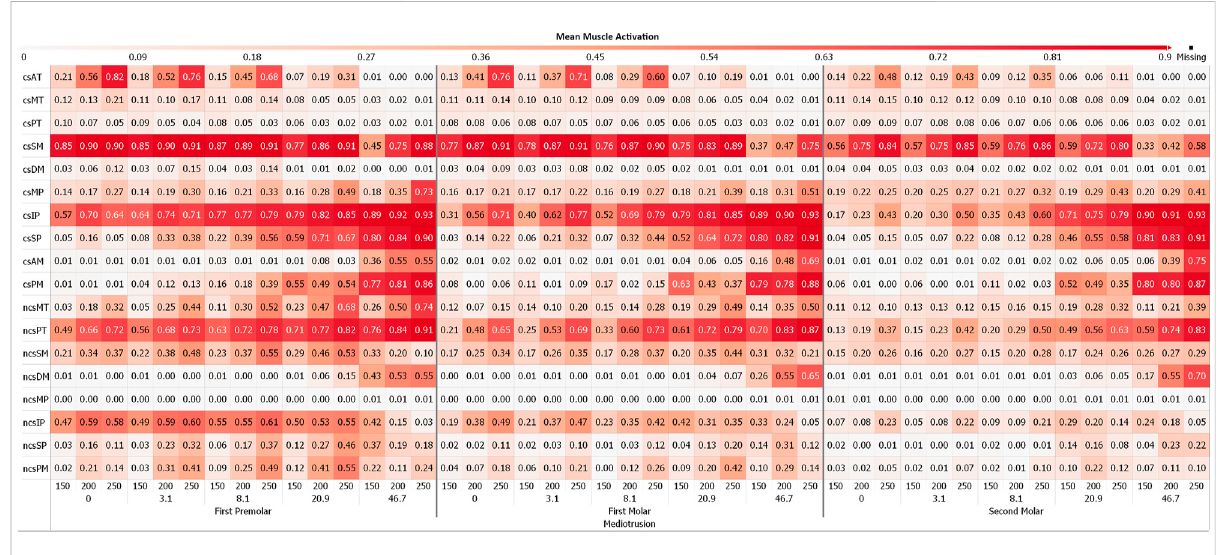
FIGURE 4 Mean muscle activation for all muscles with an activation > 20% for mediotrusive movements; 0, 3.1, 8,1, 20.9 and 46.7 are tooth facet inclinations in degree; 150, 200 and 250 are the bruxing force levels in Newton; contact side (cs) and non-contact side (ncs); AT, anterior part of temporalis; MT, medial partof temporalis; PT, posterior partoftemporalis; SM, super fi cialhead ofthemasseter;DM, deep headof themasseter; MP, medial pterygoid; IP, inferior head of lateral pterygoid; SP, superior head of lateral pterygoid; AM, anterior mylohyoid; PM, posterior mylohyoid.